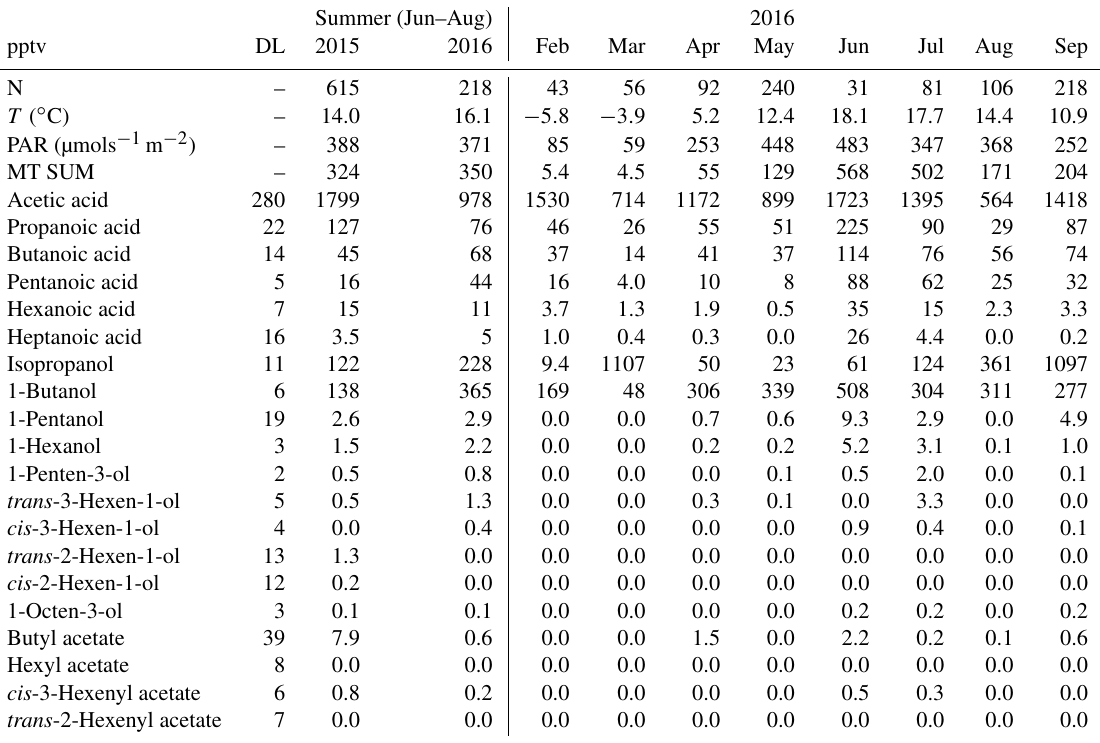
Table 2. Mean concentrations of VOCs measured in summer (June–August) 2015 and 2016 (GC-MS2) and monthly mean concentrations (pptv) in February–September 2016 with mean temperature ( T ) and photosynthetically active radiation (PAR). N : number of measurements; DL: detection limit; “–” indicates a missing